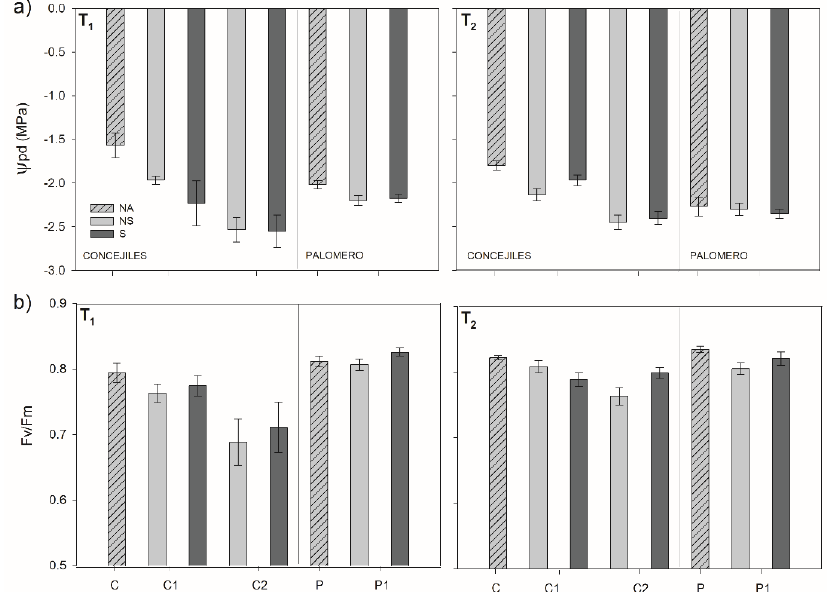
Figure 7. Panel ( a ) Water potentials measured at predawn ( Ψ pd) measured in each pine stand and disease degree, for both surveys T1 and T2. The striped dark gray bars show the values for the NA-trees; the smooth light gray bars show the values for the NS-trees; the smooth dark gray bars show the values for the S-tees. Values are the mean ± SE for n = 6 pines per stand and disease degree. Panel ( b ) Maximum PSII photochemical e ffi ciency (Fv / Fm), measured in each pine stand and disease degree, for both surveys T1 and T2. The striped dark gray bars show the values for the NA-trees; the smooth light